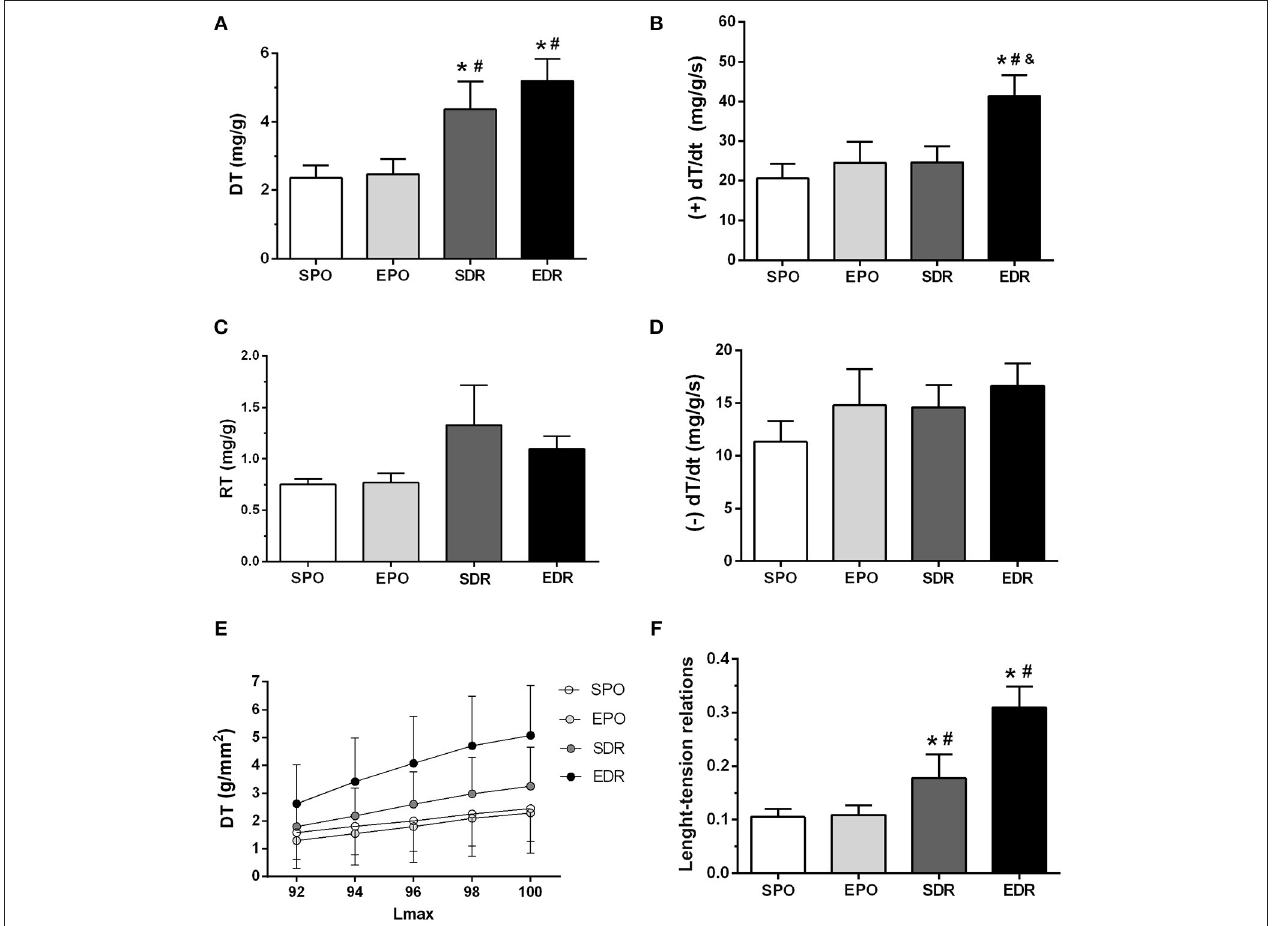
FIGURE 2 | Papillary muscle parameters. (A) DT, developed tension. (B) + dT/dt, maximum positive derivative. (C) RT, resting tension. (D) –dT/dt, maximum negative derivative. (E) Plots of DT (g/mm 2 × %Lmax). (F) Length-active tension relations slopes. Differences were evaluated by two-way ANOVA followed by post-hoc Bonferroni test. * p < 0.05 vs. SPO; # p < 0.05 vs. EPO; & p < 0.05 vs.